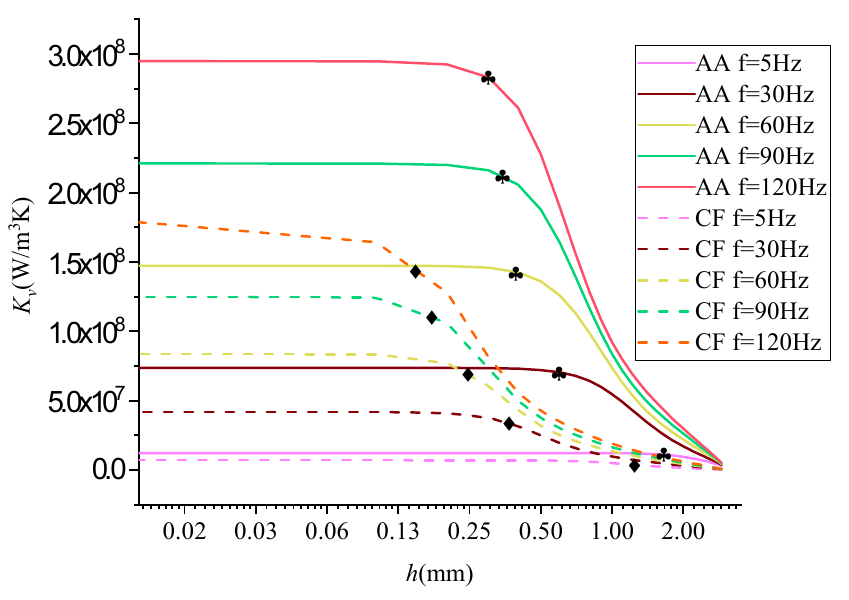
Figure 13. Variation in K v with wall thickness h.